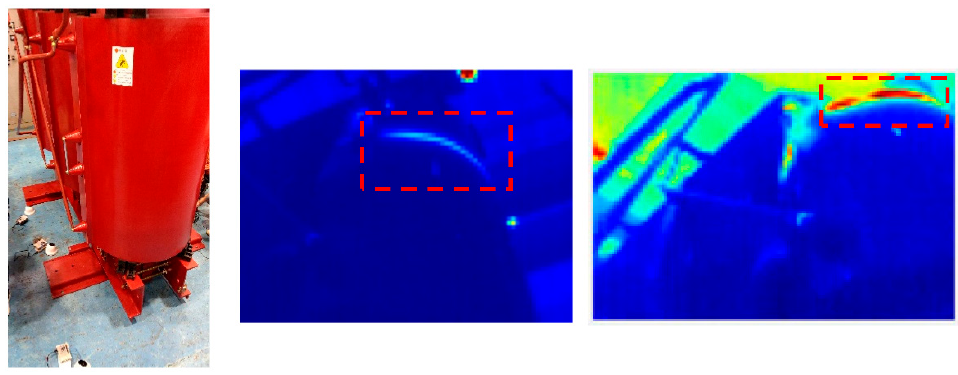
Figure 6. The thermal imaging of the cast-resin transformer with interturn short-circuited